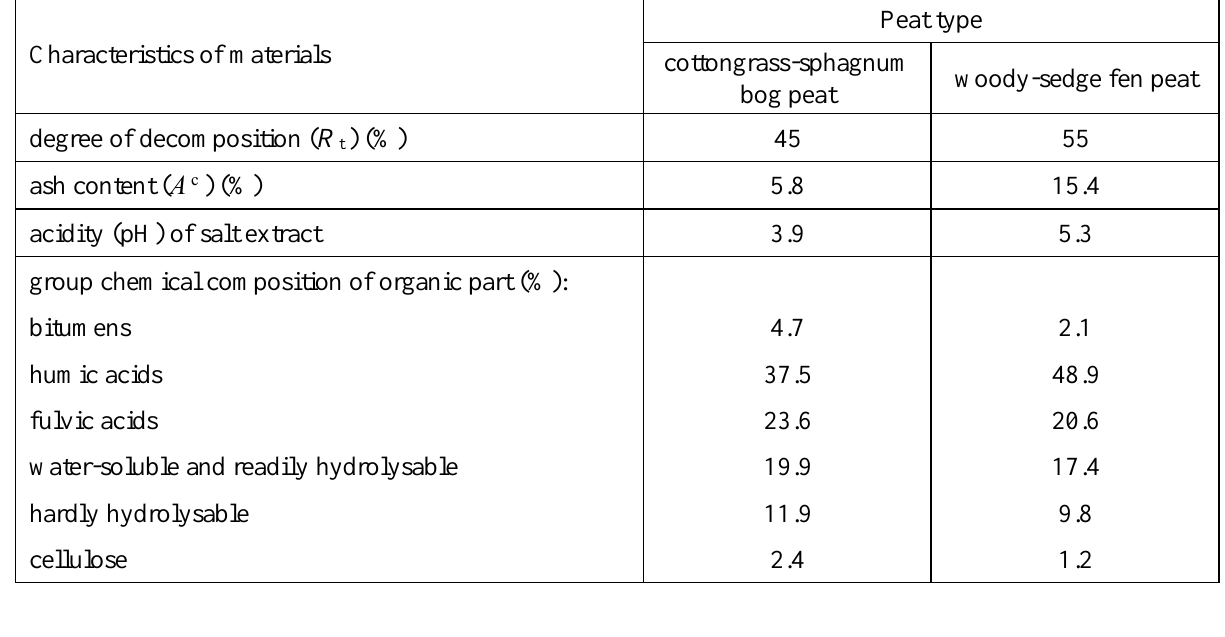
Characteristics of materials